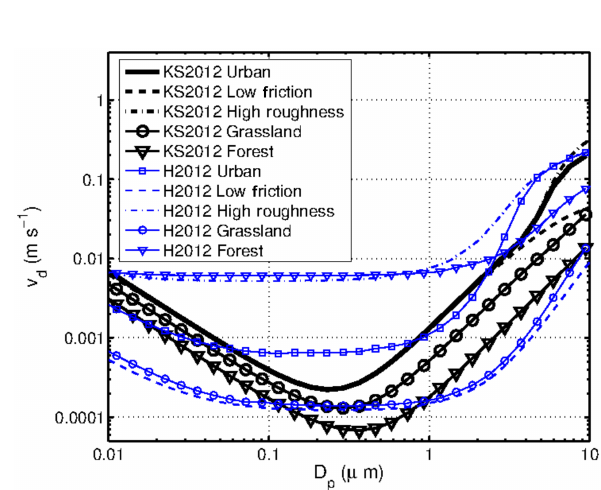
Figure 2. Dry deposition velocity, ν d (in ms − 1 ) as function of par- ticle diameter D p (in µm), using a particle density of 1400kgm − 3 . The results with the model of Kouznetsov and Sofiev (2012) (KS2012) are shown as black lines and the results with the model of Hussein et al. (2012) (H2012) are shown as blue lines. The curve of “KS2012 Urban” (thick black line) represents the dry deposition parameterization that is used in all model runs with MAFOR. The curves for cases “KS2012 Low Friction” (dashed black line) and “KS2012 High Roughness” (dash-dotted black line) partly overlay with the curve for “KS2012